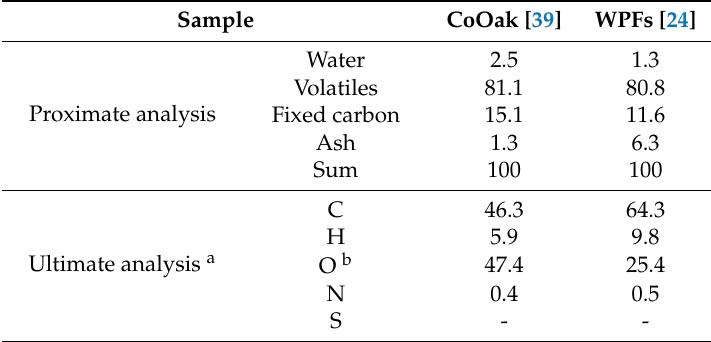
Table 2. Physicochemical characteristics of CoOak and WPFs.